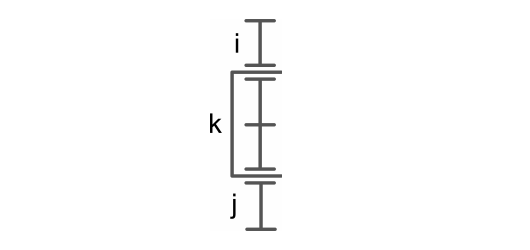
Figure 5. Basic structure of a planetary gear